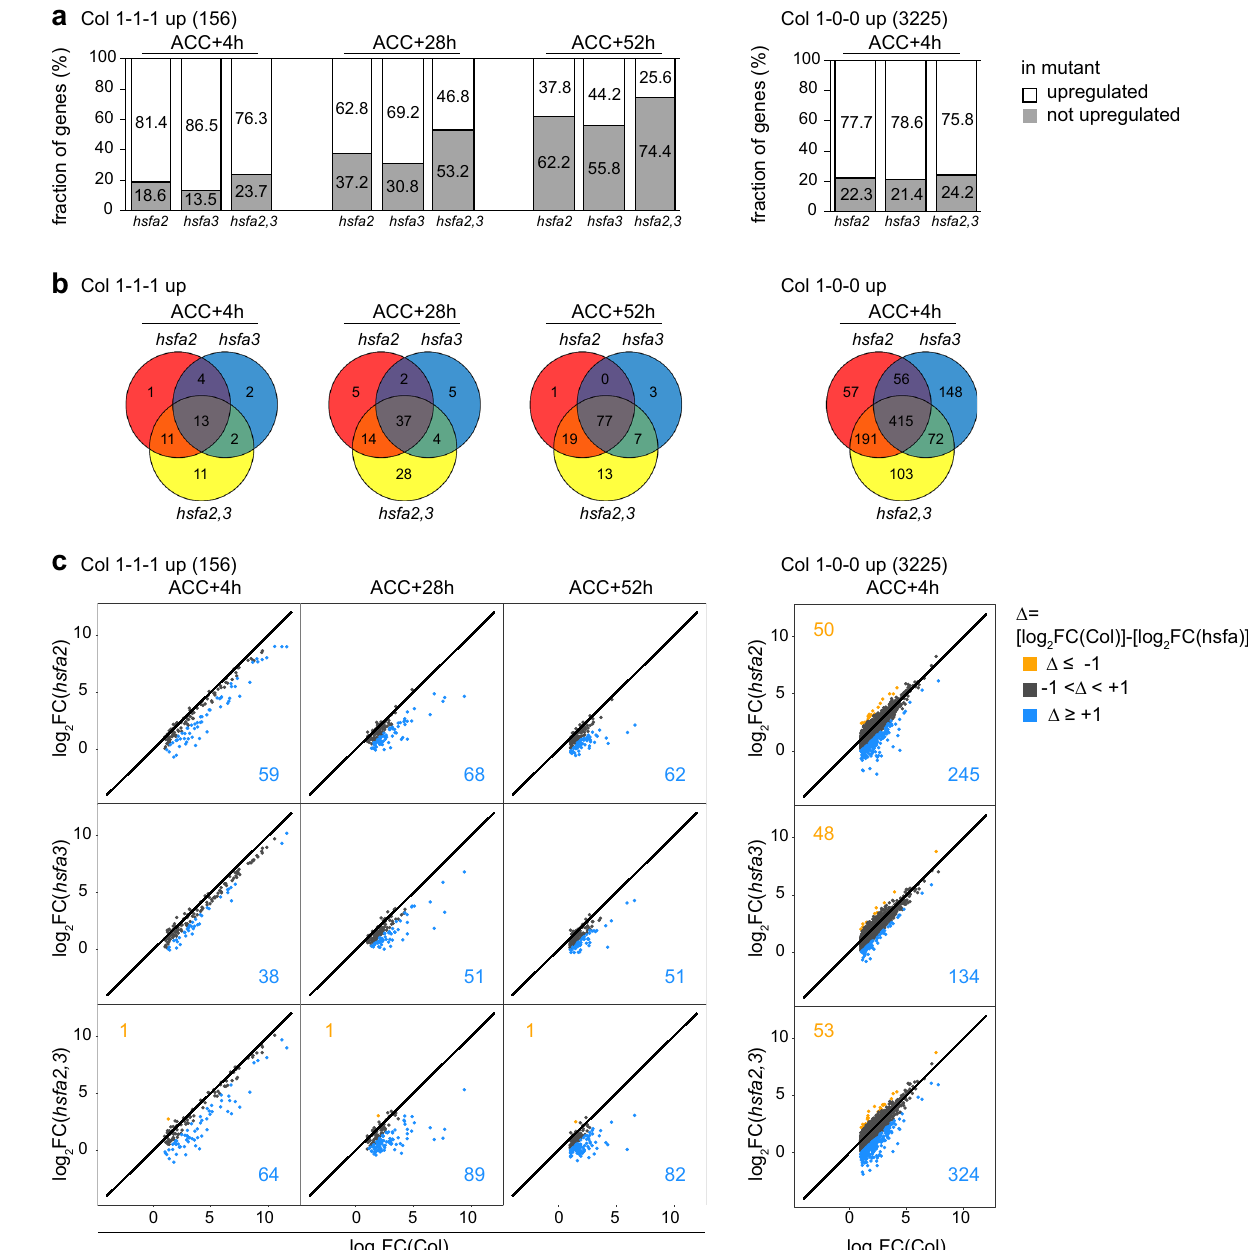
Fig. 6 HSFA2 and HSFA3 jointly promote type I transcriptional memory in a genome-wide manner. Genome-wide transcriptome pro fi ling by RNA-seq analysis identi fi es 156 HS memory genes with sustained induction above no-HS levels (log 2 FC > 1, p < 0.05) at 4 h (ACC + 4 h), 28 h (ACC + 28 h), and 52 h (ACC + 52 h) after end of ACC treatment in Col (1-1-1 up) and 3225 genes that are induced above no-HS levels only 4 h after end of ACC treatment in Col (1-0-0 up). a Fraction of 1-1-1 up (Col) and of 1-0-0 up (Col) genes that are no longer upregulated in hsfa2 , hsfa3-1 (hsfa3), and hsfa2 hsfa3-1 (hsfa23) mutants relative to their no-HS expression (log 2 FC ≤ 1 OR log 2 FC > 1 AND p > 0.05, blue; log 2 FC > 1 AND p > 0.05, gray). b Overlap of genes with loss of upregulation relative to no-HS expression (log 2 FC ≤ 1 OR log 2 FC > 1 AND p > 0.05) in hsfa2 , hsfa3-1 (hsfa3), or hsfa2 hsfa3-1 (hsfa23) mutants among 1-1-1 up (Col) and 1-0-0 up (Col) genes. c Pairwise comparison of log 2 FCs relative to no-HS expression between Col and hsfa2 , hsfa3-1 (hsfa3) or hsfa2 hsfa3-1 (hsfa23) mutants of 1-1-1 up (Col) and 1-0-0 up (Col) genes. Genes in orange are more strongly induced in the mutant, genes in blue are less induced in the mutant. Colored numbers indicate the number of genes in the respective